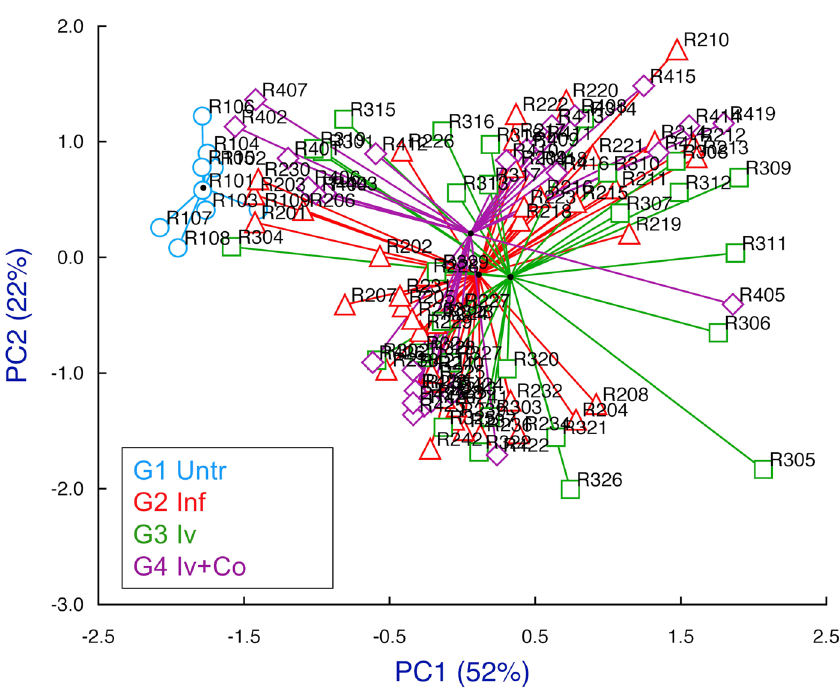
Figure 8. Multivariate study of principal components highlighting each study group and searching their reference centroid at eight weeks post-infection. Groups: mice treated with ivermectin and infected with 150 cercariae of, S. mansoni (Iv); treated with ivermectin + cobicistat (Iv + Co) and infected; infected only with 150 cercariae of (Inf): and an untreated and uninfected control group